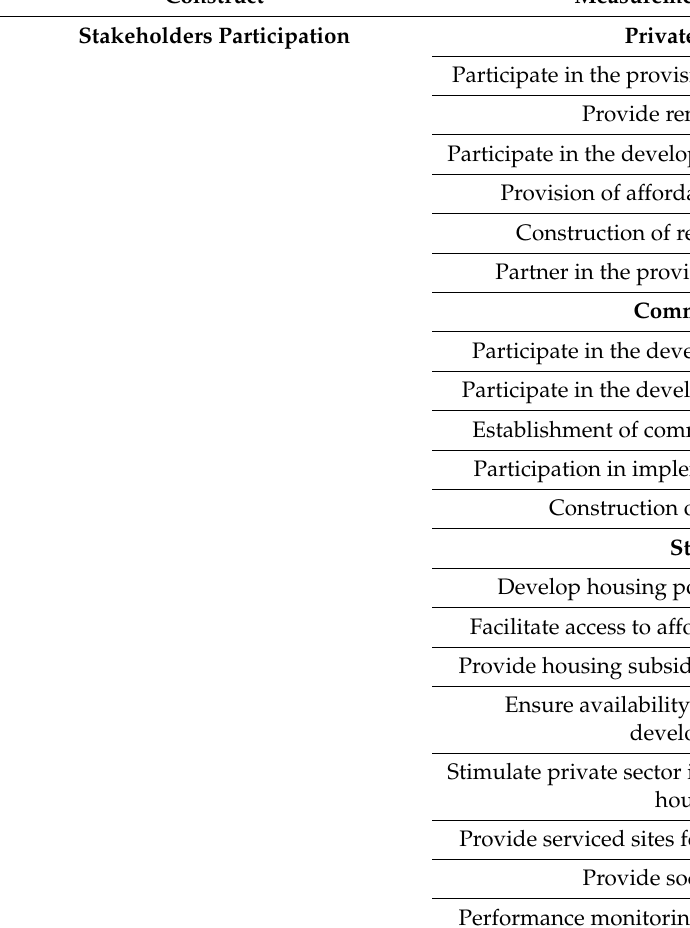
Table 1. Measurement indicator variables for stakeholders’ participation.